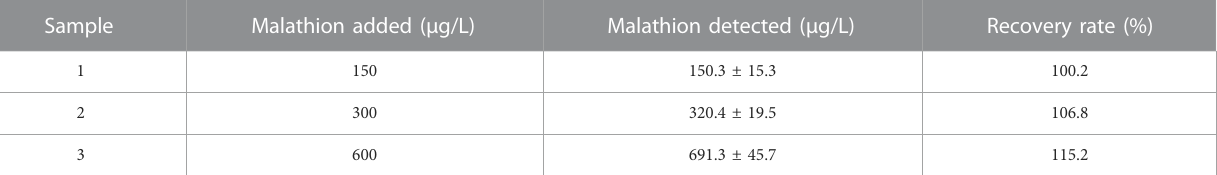
TABLE 3 The recovery tests of malathion spiked in tap water using HPLC.